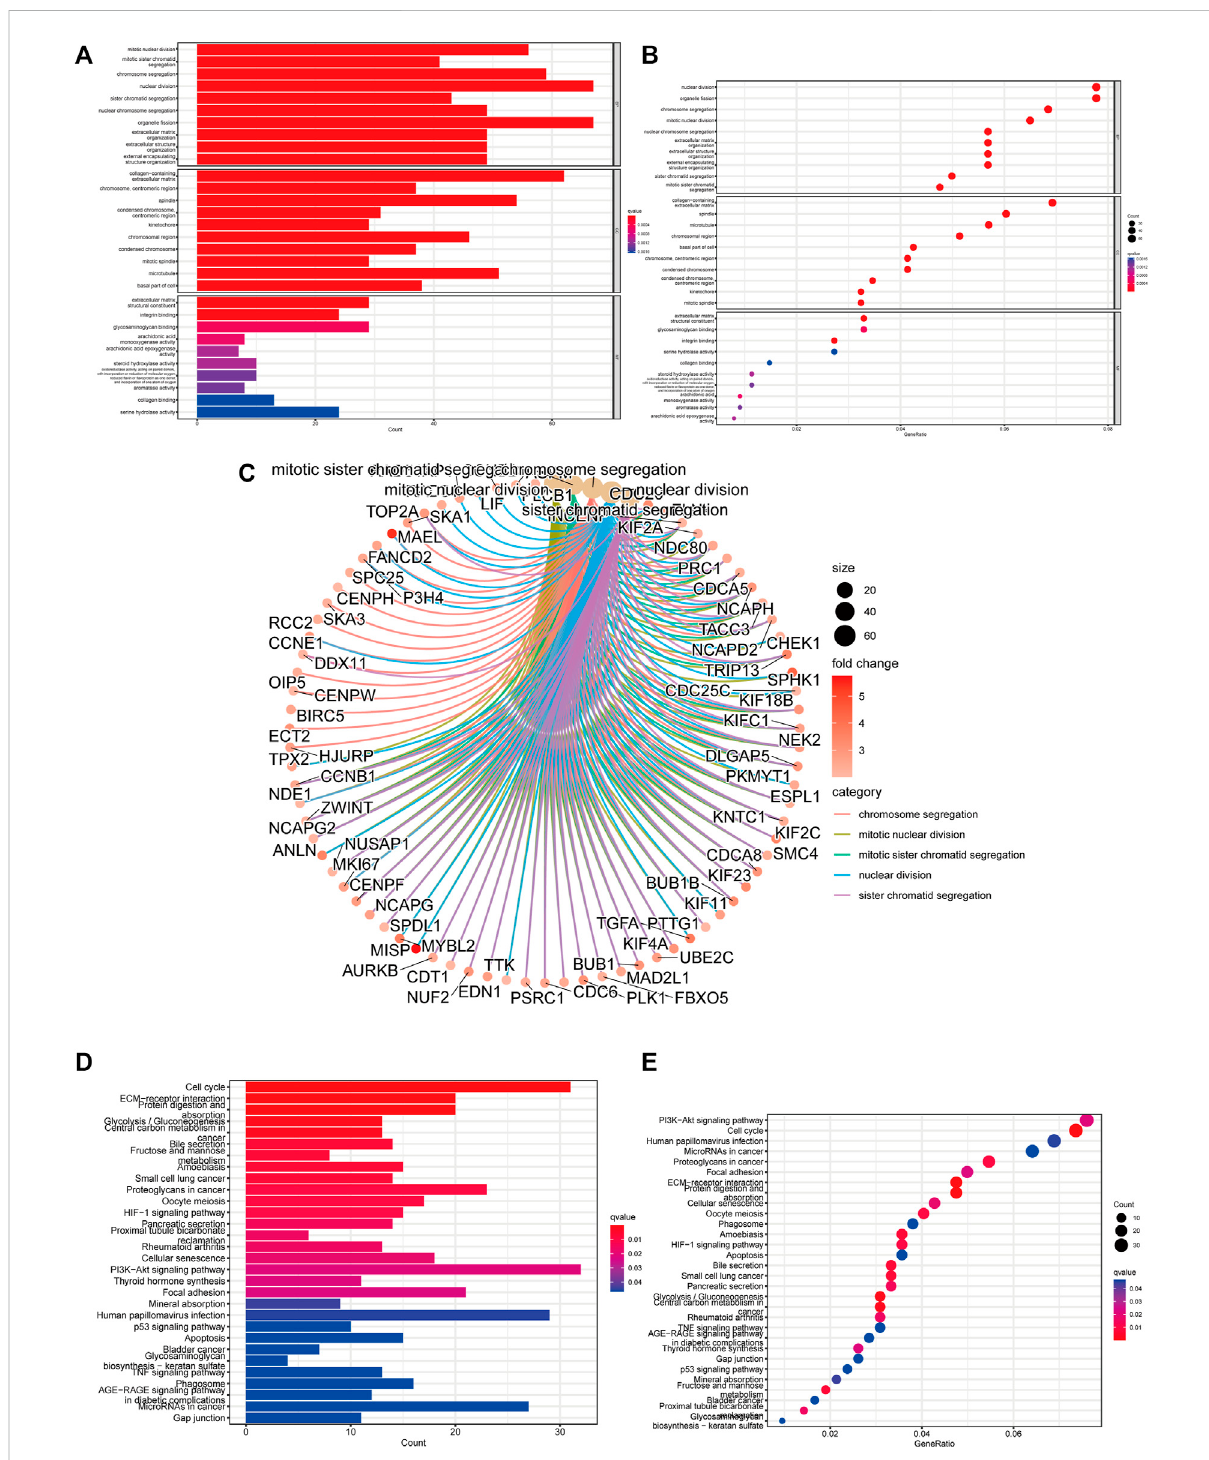
FIGURE 8 Function and pathways enrichment analysis of m5C-related lncRNAs. (A – C) Visualization of the enriched biological processes by GO analysis. (D,E) KEGG analysis displaying the enriched signaling pathways related to risk